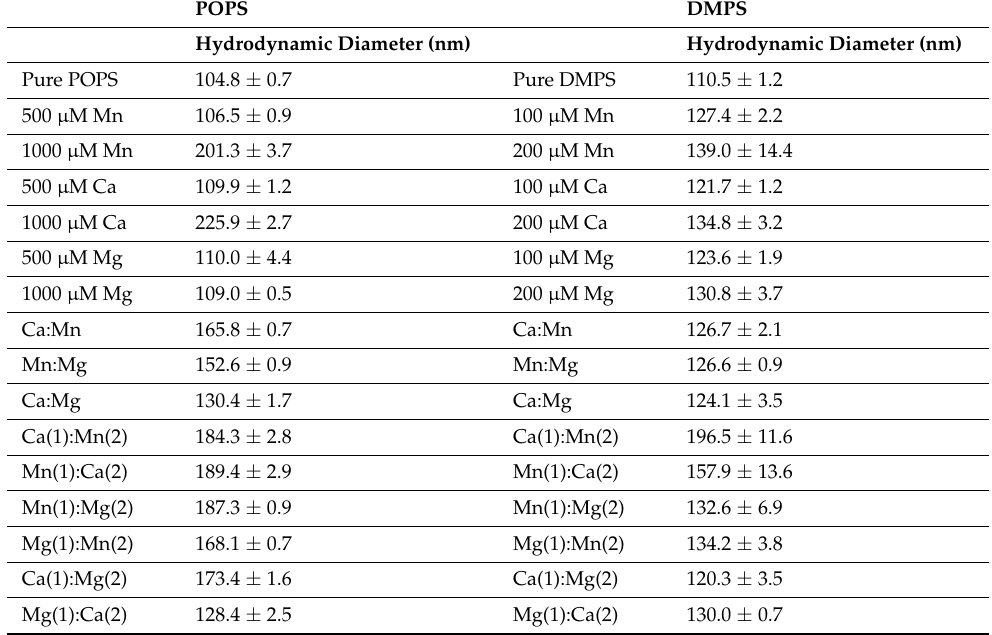
Table 8. Tabulated hydrodynamic diameter of POPS and DMPS lipid with Mn, Ca, Mg and metal